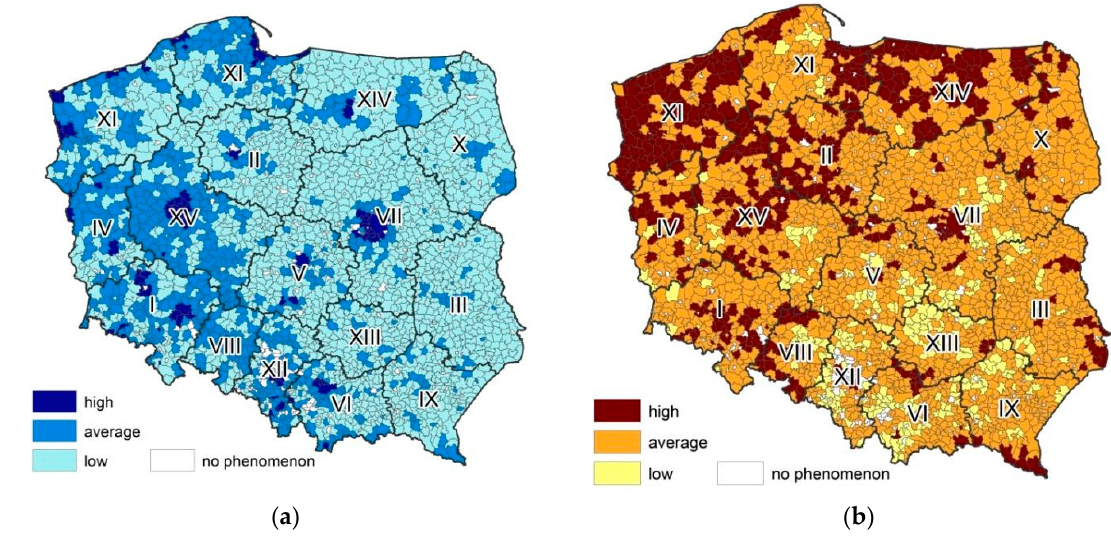
Figure 3. The level of socioeconomic development (( a ) LSED) and the level of agricultural development (( b ) LAD). Source: own elaboration on [66–68,70,71].